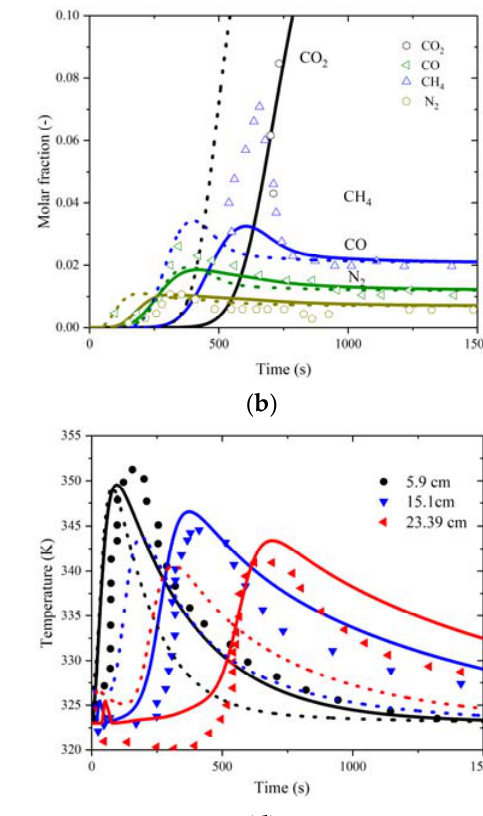
6 of 14 Figure 1. Adsorption isotherms of H 2 ( a ), CO 2 ( b ), N 2 ( c ), CH 4 ( d ), and CO ( e ) on R2030 and AC5-KS. Symbols: Experimental data from [30]. Lines: Fitting with the extended Langmuir model of the AC5-KS (—) and of the R2030 (- - -). 3.2. Breakthrough Curves Validation of AC5-KS and R2030 Adsorption Beds The molar fraction simulated results of the five-component mixture in AC5-KS and R2030 are shown in Figure 2, which agree well with experiment results. From Figure 2, it can be observed that the breakthrough time of each component was different. Hydrogen was slightly adsorbed and reached the breakthrough point rapidly. Nitrogen was the first gas to break through the adsorption bed, followed by carbon monoxide, and methane and carbon dioxide were the last to break through the adsorption bed. The main reason is that the adsorption performance of different gases is not the same. The adsorption capacity of AC5-KS and R2030 adsorbents for each gas component is as follows: CO 2 > CH 4 > CO > N 2 > H 2 . In the adsorption process, the weak adsorbate is desorbed from the adsorption bed and reintegrated into the gas flow, so an apparent peak appears in the breakthrough curve. As shown in Figure 2, adsorbate in AC5-KS breakthroughs the adsorption bed slower than that in R2030, and the breakthrough curve’s peak in AC5-KS is lower than